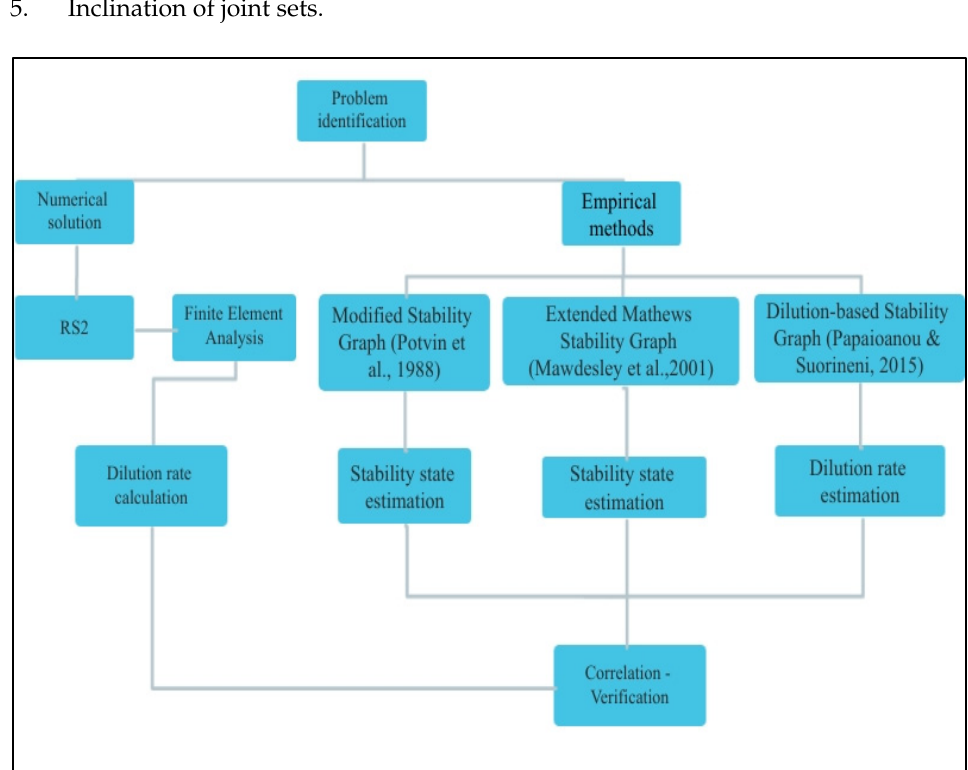
Figure 3. Flow chart of the parametric analysis. Table 2. The list of examined parameters’ values.